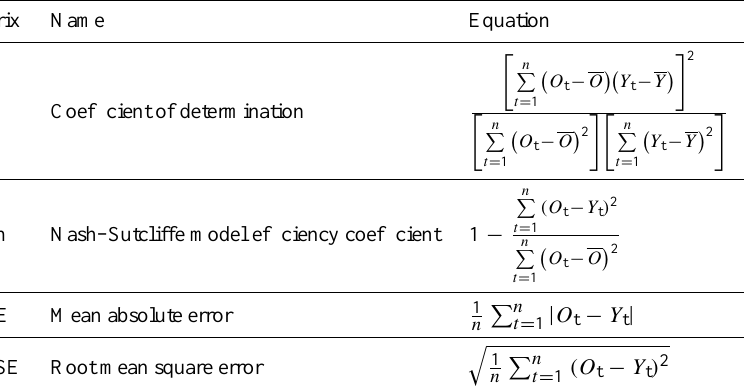
Table 2. Matrices used for model calibration and